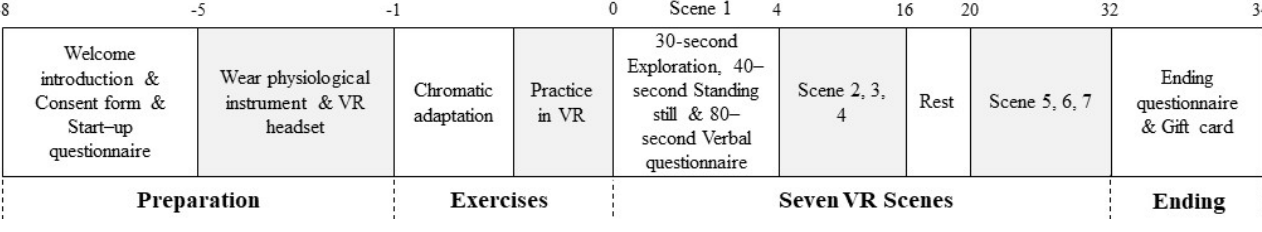
Figure 5. VR experiment protocol.